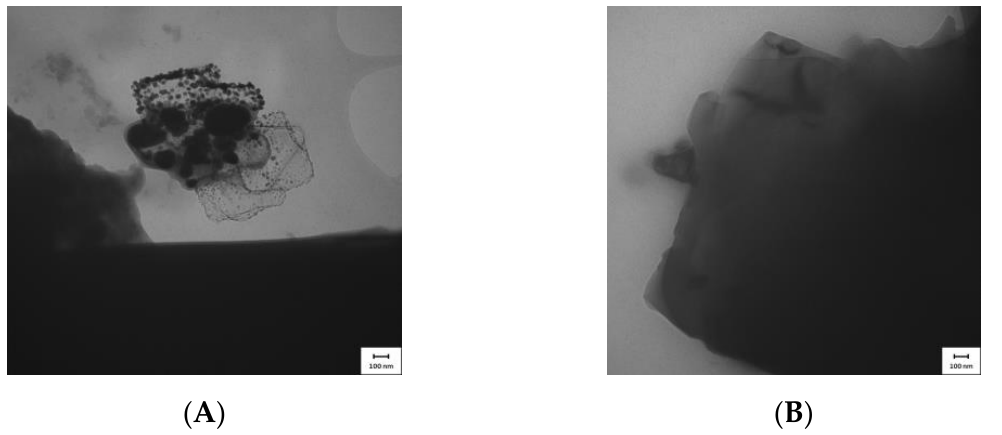
Figure 8. Transmission electron micrographs of ( A ) Zn-AlPO 4 and ( B ) AlPO 4 heat-treated at 1000 ◦ C.